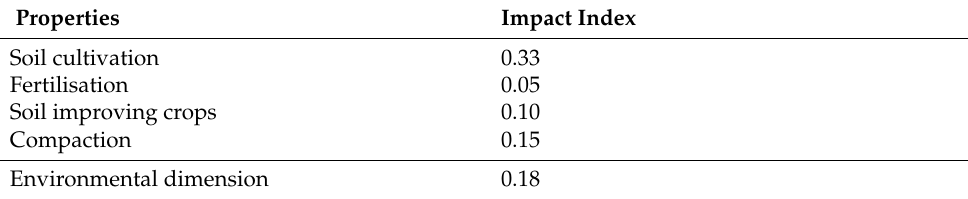
Table 4. Outcomes of the assessment of the environmental dimension with regard to the key topics.